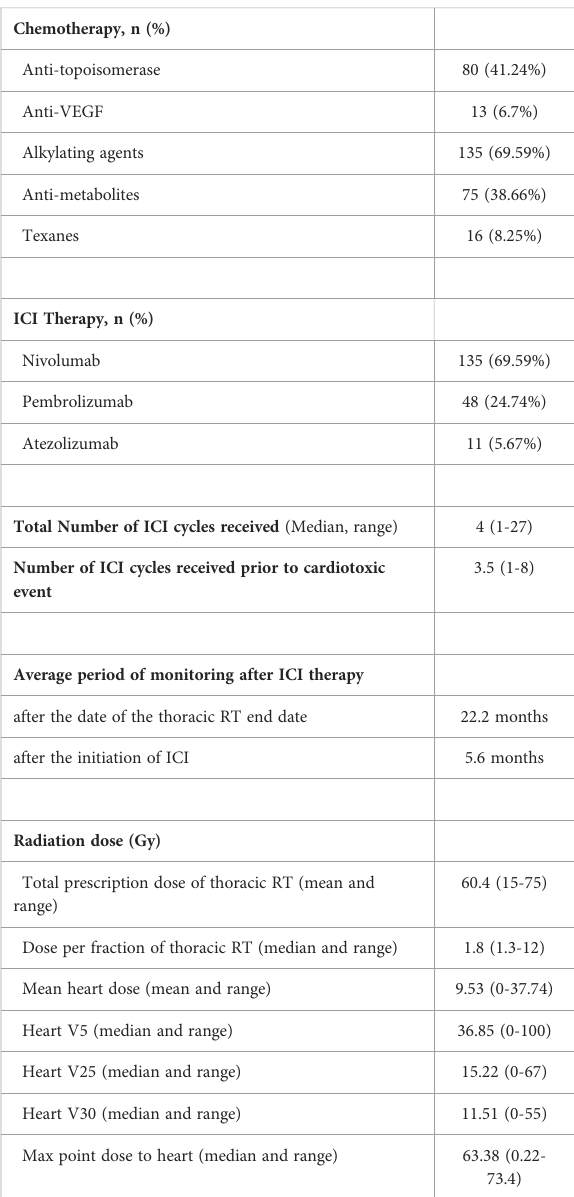
TABLE 3 Chemotherapy and ICI therapy strati fi cation and radiation treatment